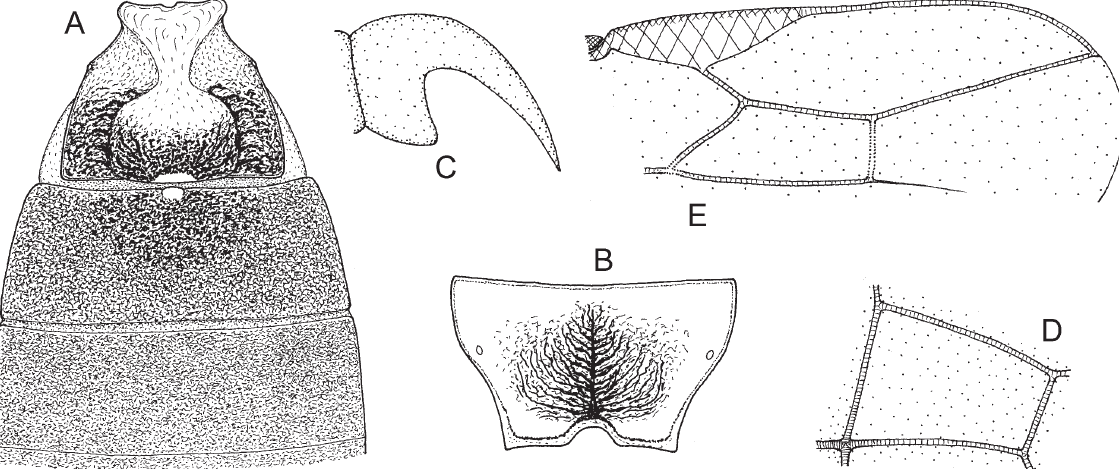
Fig. 62. Bracon ( Bracon ) alutaceus Szépligeti, 1901, ♀ lectotype. A . Tergites 1-3. B . Propodeum. C . Claw. D . First discal cell of right forewing. E . Distal part of right